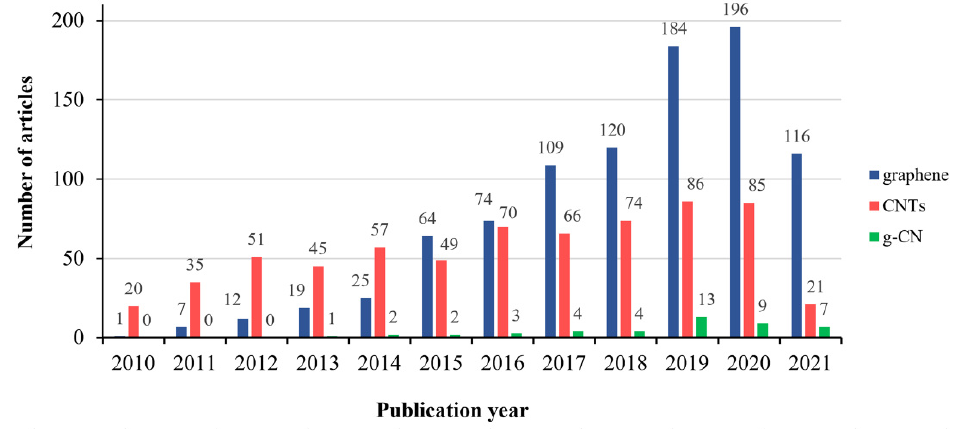
Figure 1. The number of publications related to graphene, CNTs, and g-C 3 N 4 in textiles since 2010, retrieved using the keywords “graphene or reduced graphene oxide or rGO or r-GO” (“CNTs or carbon nanotubes,” “graphitic carbon nitride or carbon nitride or g-C 3 N 4 or g-CN”) in the title and the words “textile of fabric or fabrics” in the abstract (Source: Web of Science (https://www.webofscience.com/wos/woscc/basic-search), accessed on 25 July 2021).